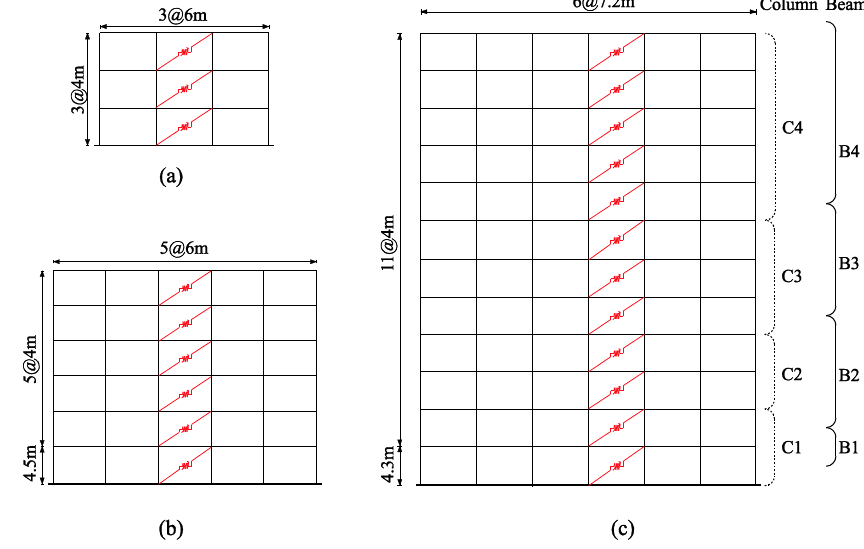
Figure 4. Analysis model: ( a ) a three-story steel moment resisting frame with dampers; ( b ) a six-story steel moment resisting frame with dampers; and ( c ) a twelve-story steel moment resisting frame with dampers.